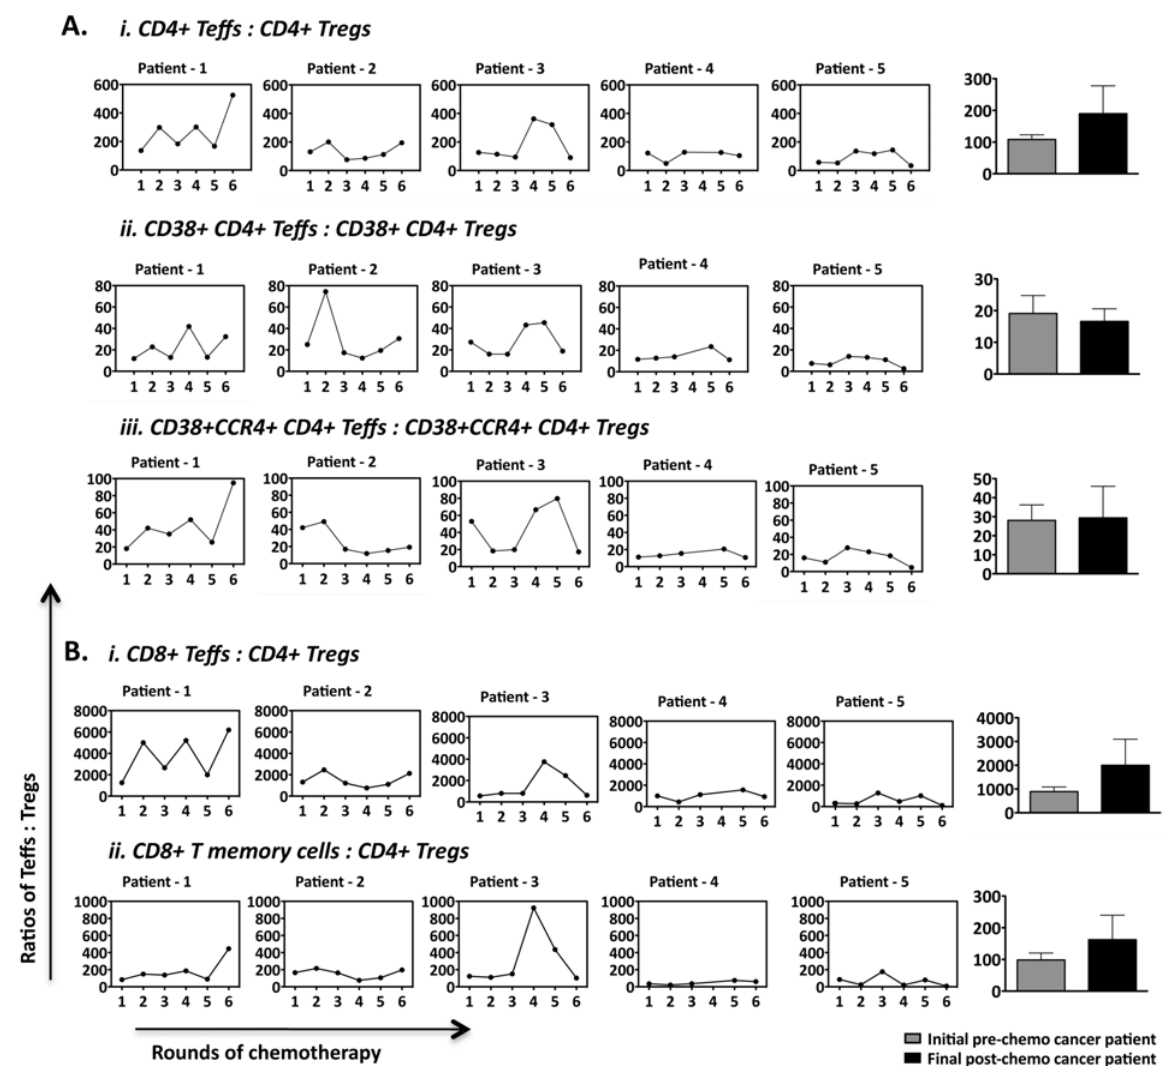
Figure 6. Ratio of CD4+ and CD8+ T cell subsets to Treg subsets identified within PBMCs of cancer patients over standard chemotherapeutic treatment. The ratios of ( A ) CD4+ T cell subsets to their corresponding Treg subsets and ( B ) CD8+ T cell subset to conventional Tregs (CD4+CD25 hi FOXP3+CD127 − ) for the individual patients before each round of chemotherapy are represented here. The ratios of all five cancer patients before the first and during the last round of chemotherapy for their corresponding subsets are also shown in concurrent bar graphs (not